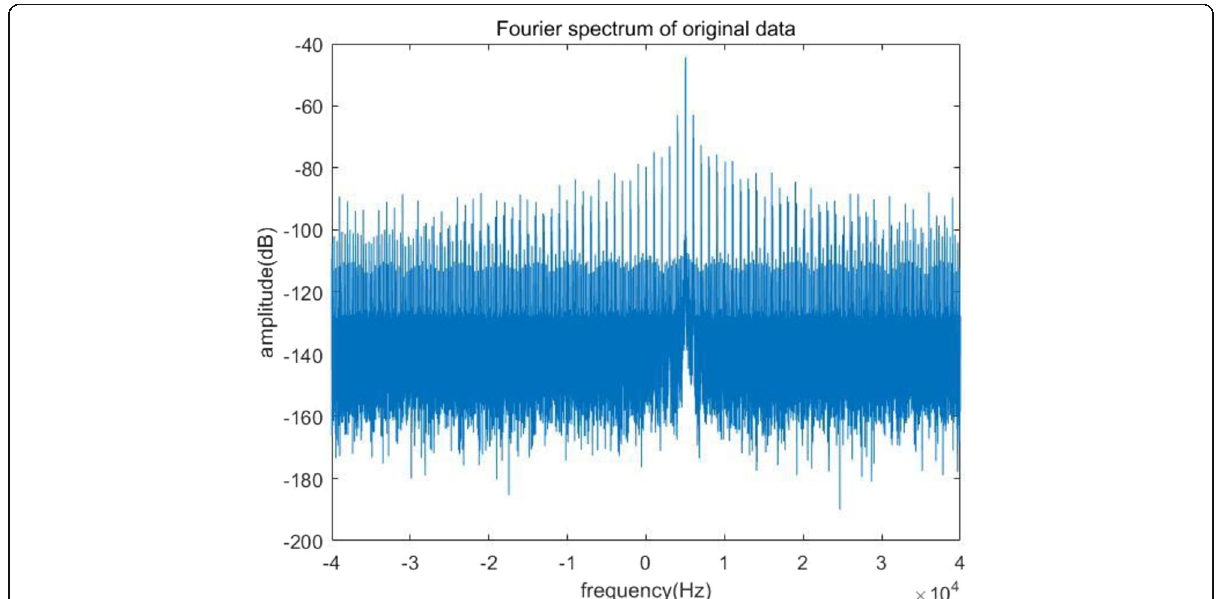
Fig. 13 Spectrum of the original signal